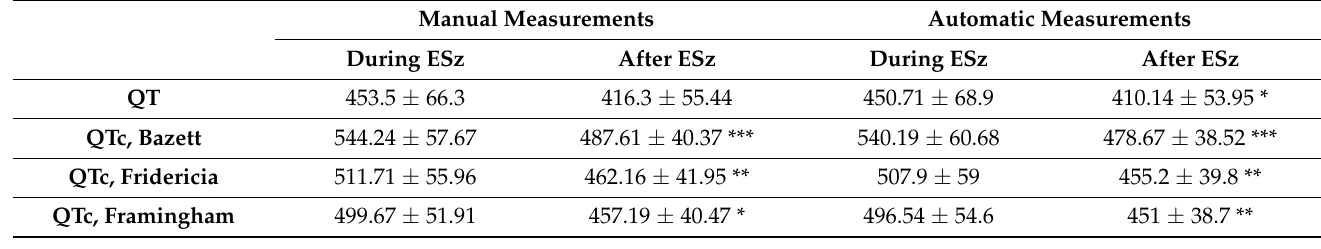
Table 1. Changes in QT and QTc intervals during electrographic seizures and 15 min after their effective suppression with barbiturate infusion. * p < 0.05, ** p < 0.01, *** p < 0.001—difference between QT and QTc before and after suppression of